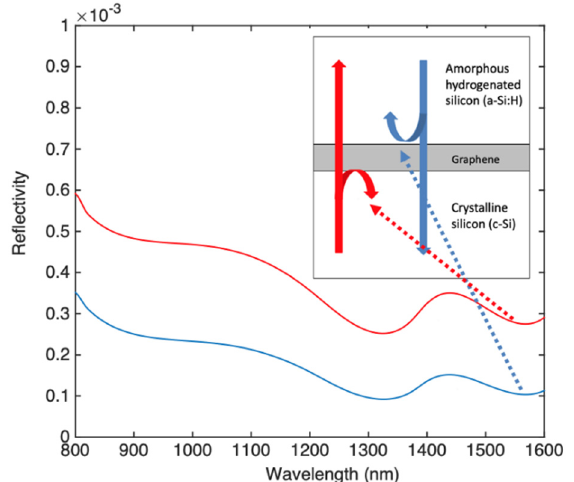
Figure 4. Reflectivity inside the cavity at the c-Si/graphene (red) and a-Si:H/graphene (blue) interfaces.